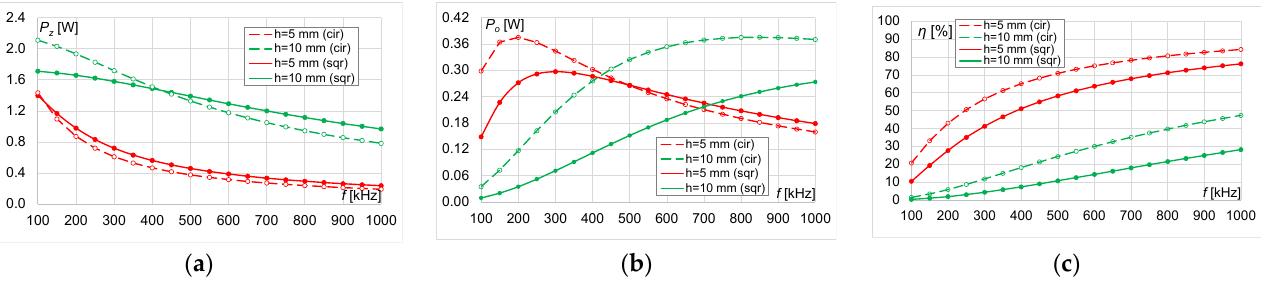
Figure 8. Results for circular and square coils with r = 10 mm and number of turns n = 15 at different distances ( h = 5 mm and h = 10 mm): ( a ) transmitter power, ( b ) receiver power and ( c ) power transfer efficiency.